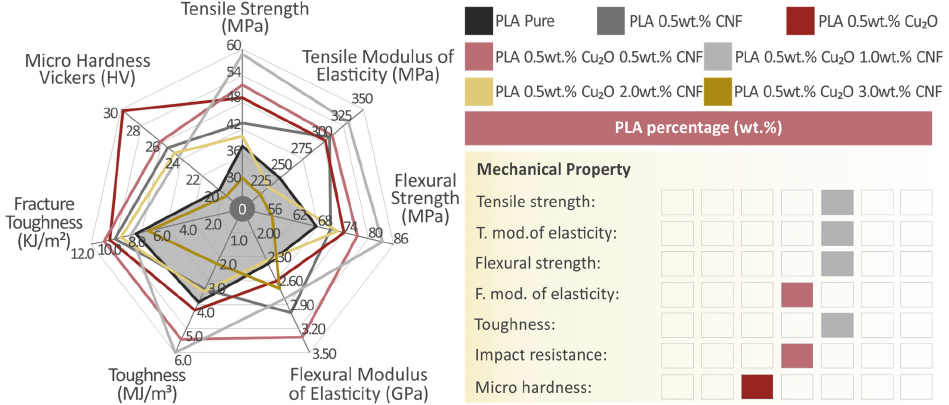
Figure 15. Spider graph summarizing the mechanical test results for all the tested materials. The material with the highest measured value in each test is indicated on the right side.